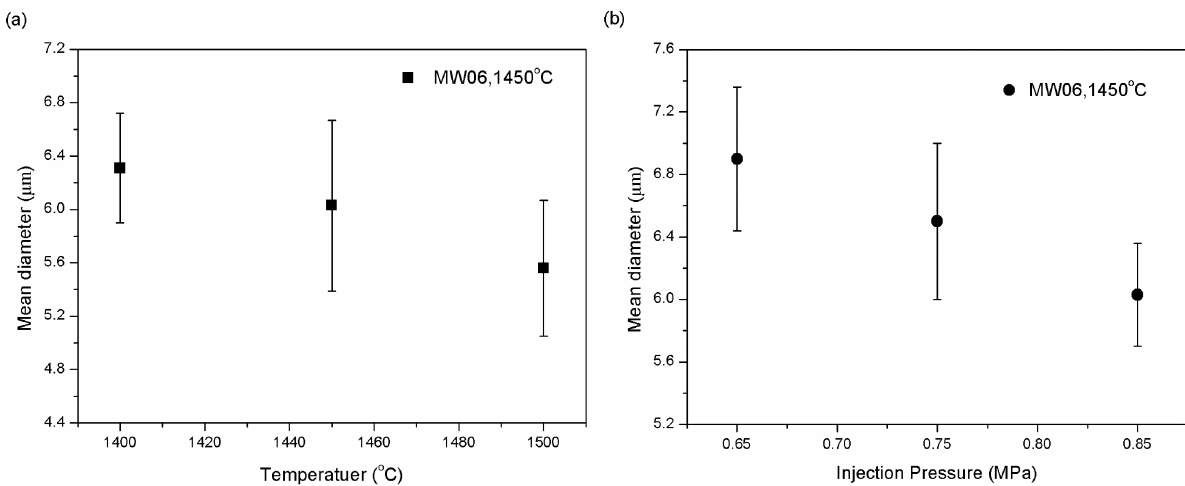
Figure 7. ( a ) The mean diameter of slag fiber dependence of the injection temperature; ( b ) The mean diameter of slag fiber dependence of the injection pressure.